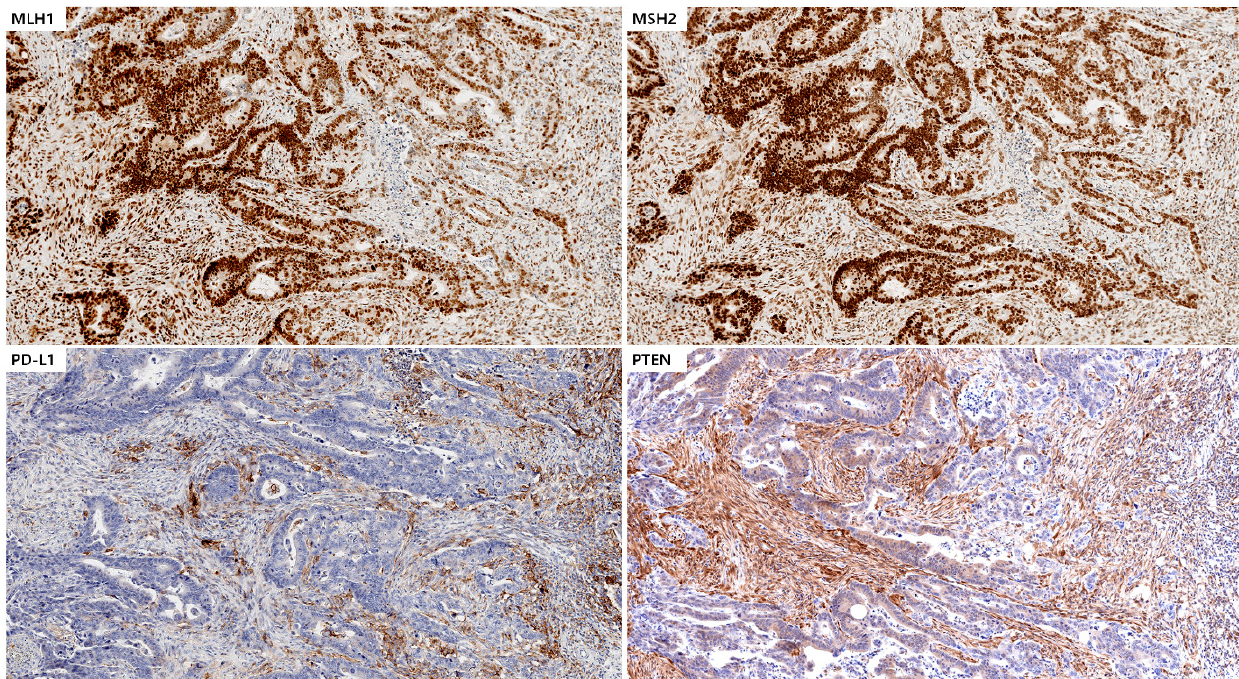
Figure 2. Immunohistochemistry of tumor sections from case #02 using antibodies targeting MLH1 and MSH2 showing the expression of mismatch repair proteins in tumor cells (mismatch repair proficiency), PD-L1 expression in lymphocytes (immune-excluded tumor microenvironment; CPS = 10), and PTEN protein loss in tumor sections. All images are at 2.0× magnification.